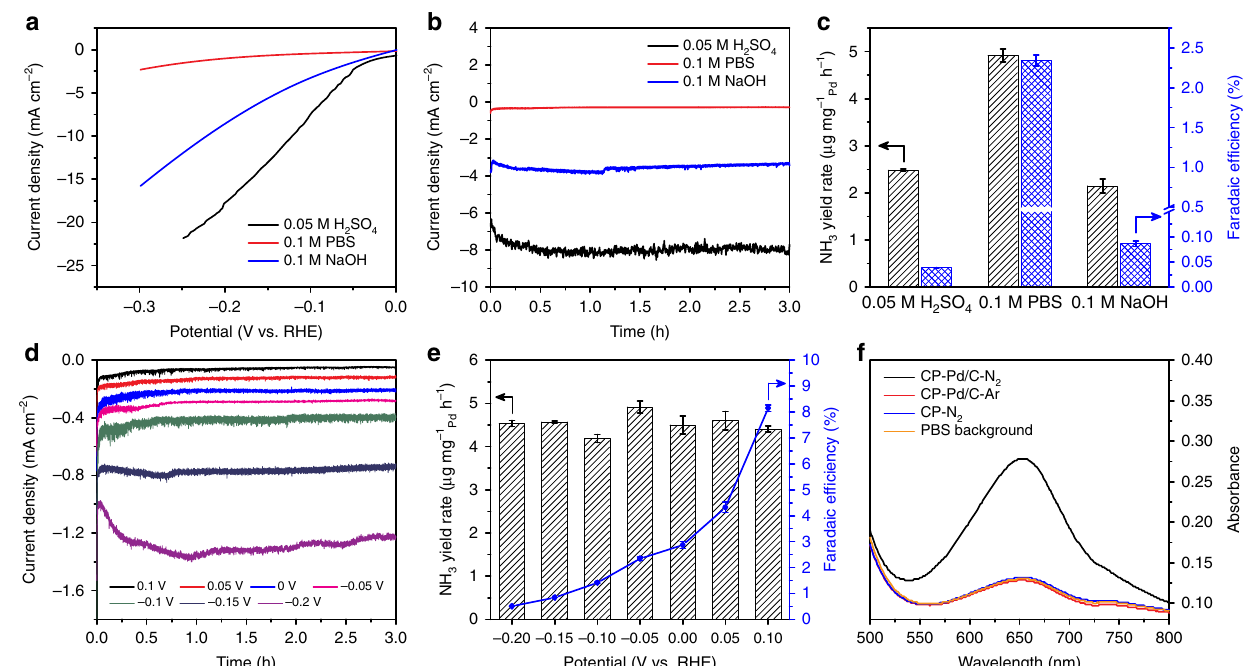
Fig. 2 Electroreduction of N 2 to NH 3 on the Pd/C catalyst. a Linear sweep voltammetric curves of the Pd/C catalyst on the glassy-carbon support measured in the three Ar-saturated electrolytes. b Chronoamperometric curves of the Pd/C catalyst on the carbon-paper support measured at − 0.05 V vs. RHE in the three N 2 -saturated electrolytes, and c corresponding NH 3 yield rates and Faradaic ef fi ciencies in the three electrolytes. d Chronoamperometric curves of the Pd/C catalyst on the carbon-paper support in N 2 -saturated 0.1 M PBS at various potentials, and e corresponding NH 3 yield rates and Faradaic ef fi ciencies at the potentials. The error bars correspond to the standard deviations of measurements over three separately prepared samples under the same conditions. f UV-vis absorption spectra of the electrolytes after electrolysis at − 0.05 V vs. RHE for 3 h under different conditions. No apparent NH 3 was detected for the control experiments with Ar-saturated electrolyte (CP-Pd/C-Ar) or without Pd catalyst (CP-N 2 ), indicating that NH 3 was produced